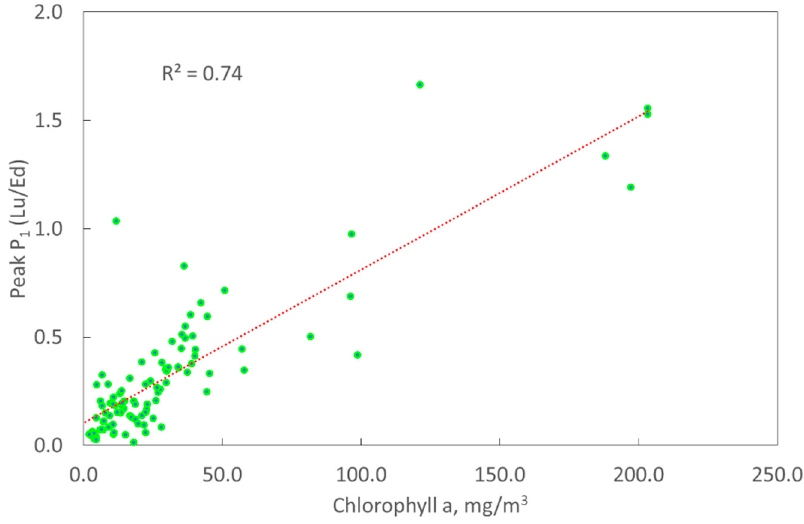
Figure 4. Correlation between the 700–720 nm peak height (P 1 , Equation (1)) and chlorophyll-a concentration in all studied Estonian and Swedish lakes.